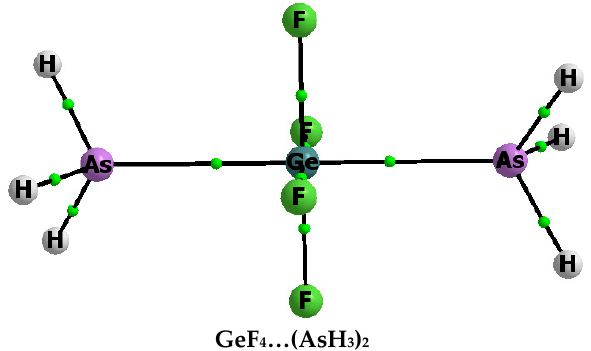
Figure 2. Molecular graph of the GeF 4 –(AsH 3 ) 2 complex; attractors are designated by big circles while bond critical points by small ones, and continuous lines correspond to bond paths.